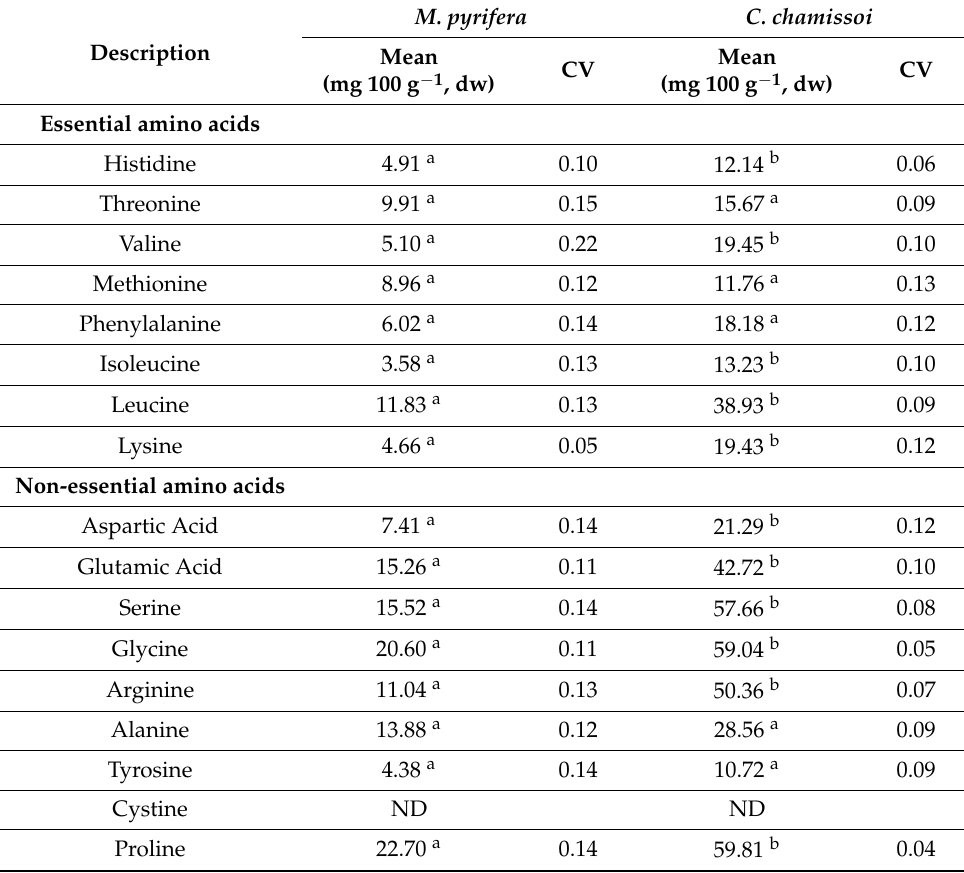
Table 2. Amino acids profile of brown ( M. pyrifera ) and red ( C. chamissoi ) Peruvian seaweed.